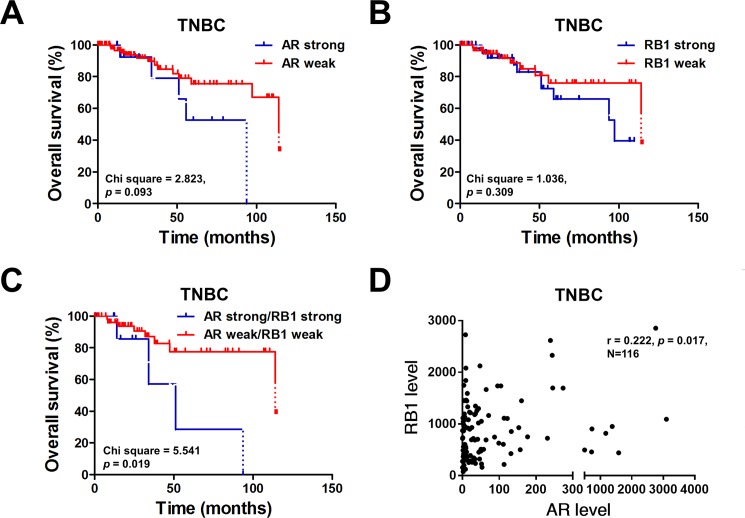
Clinical significances of AR and RB1 gene expression in patients with TNBC.(A-D) The level 3 data of mRNA RSEM (RNA-Seq by Expectation Maximization) from patients with TNBC were selected and downloaded from the TCGA and Broad GDAC Firehose data portal. The mean of AR or RB1 gene expressions were the chosen as cut-off value for separating tumors with strong and weak expression. Overall survival rates of TNBC patients were plotted against time in month for different parameters: the level of AR gene (A), the level of RB1 gene (B), and the level of AR/RB1 genes (C). The correlation between AR and RB1 mRNA expressions was analyzed by Pearson correlation analysis (D).